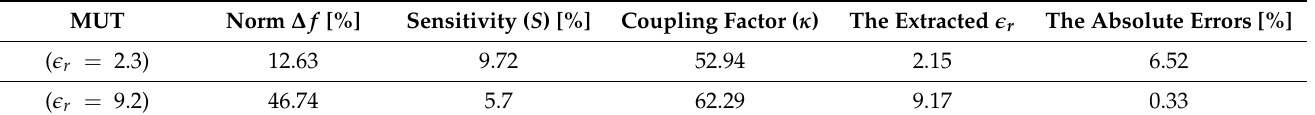
Table 4. The summarized results based on the experiment.